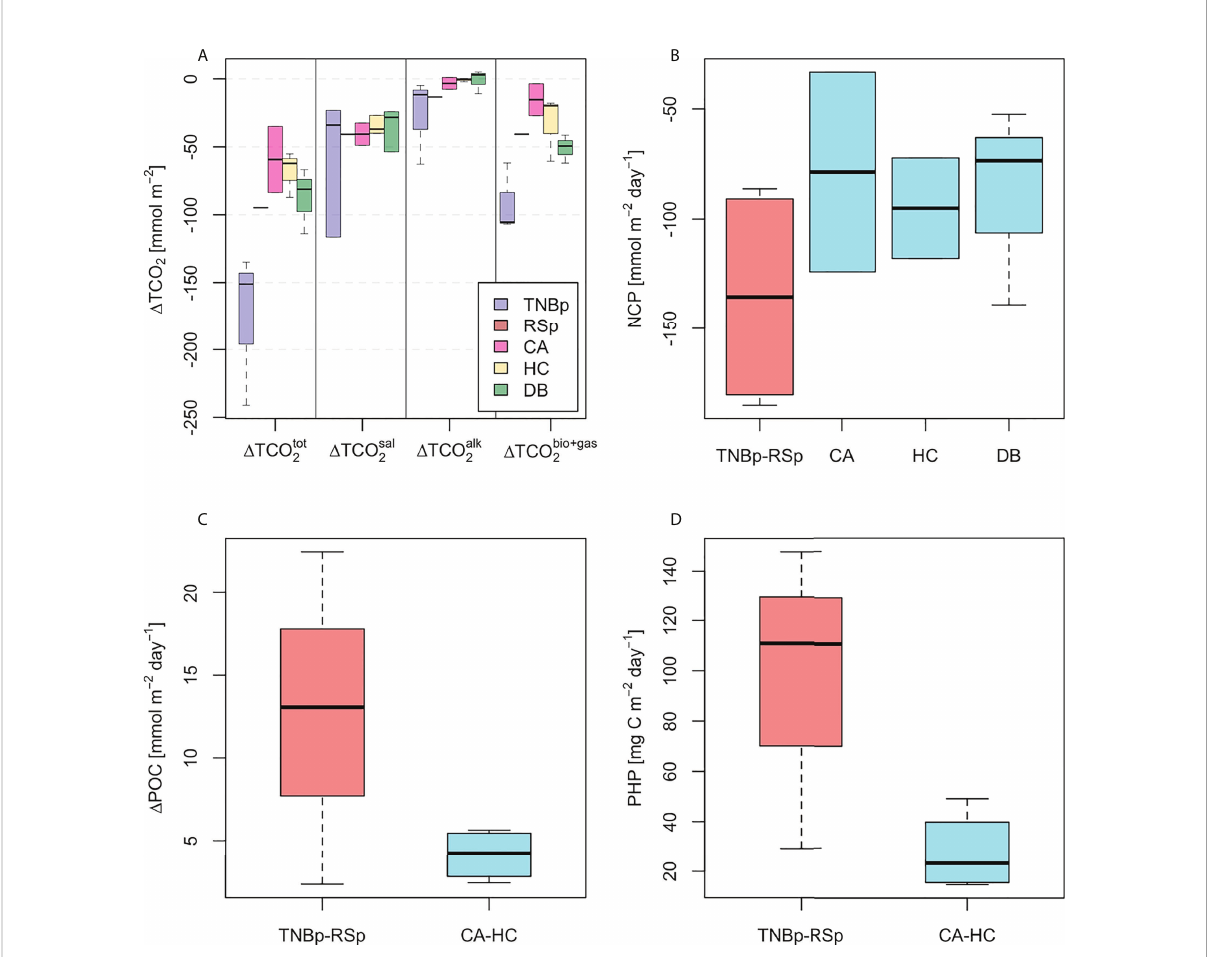
FIGURE 7 (A) Total de fi cit of TCO 2 ( D TCO tot 2 ; mmol m − 2 ) in the mixed-layer for each region and contribution from salinity ( D TCO sal 2 , mmol m − 2 ), carbonate mineral processes ( D TCO alk 2 , mmol m − 2 ), biology, and gas exchange ( D TCO bio + gas